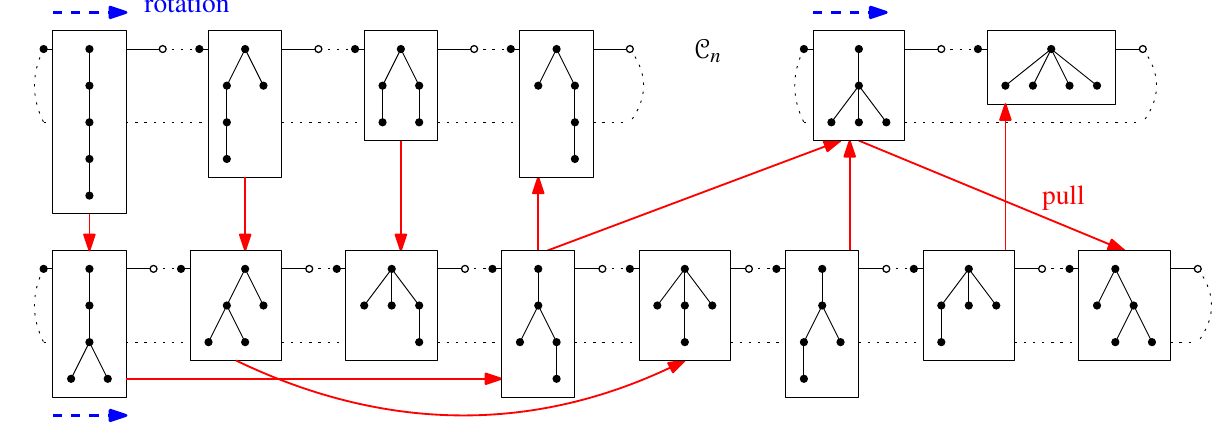
Figure 1: Cycle structure of the 2-factor C n and auxiliary graph H n for n =